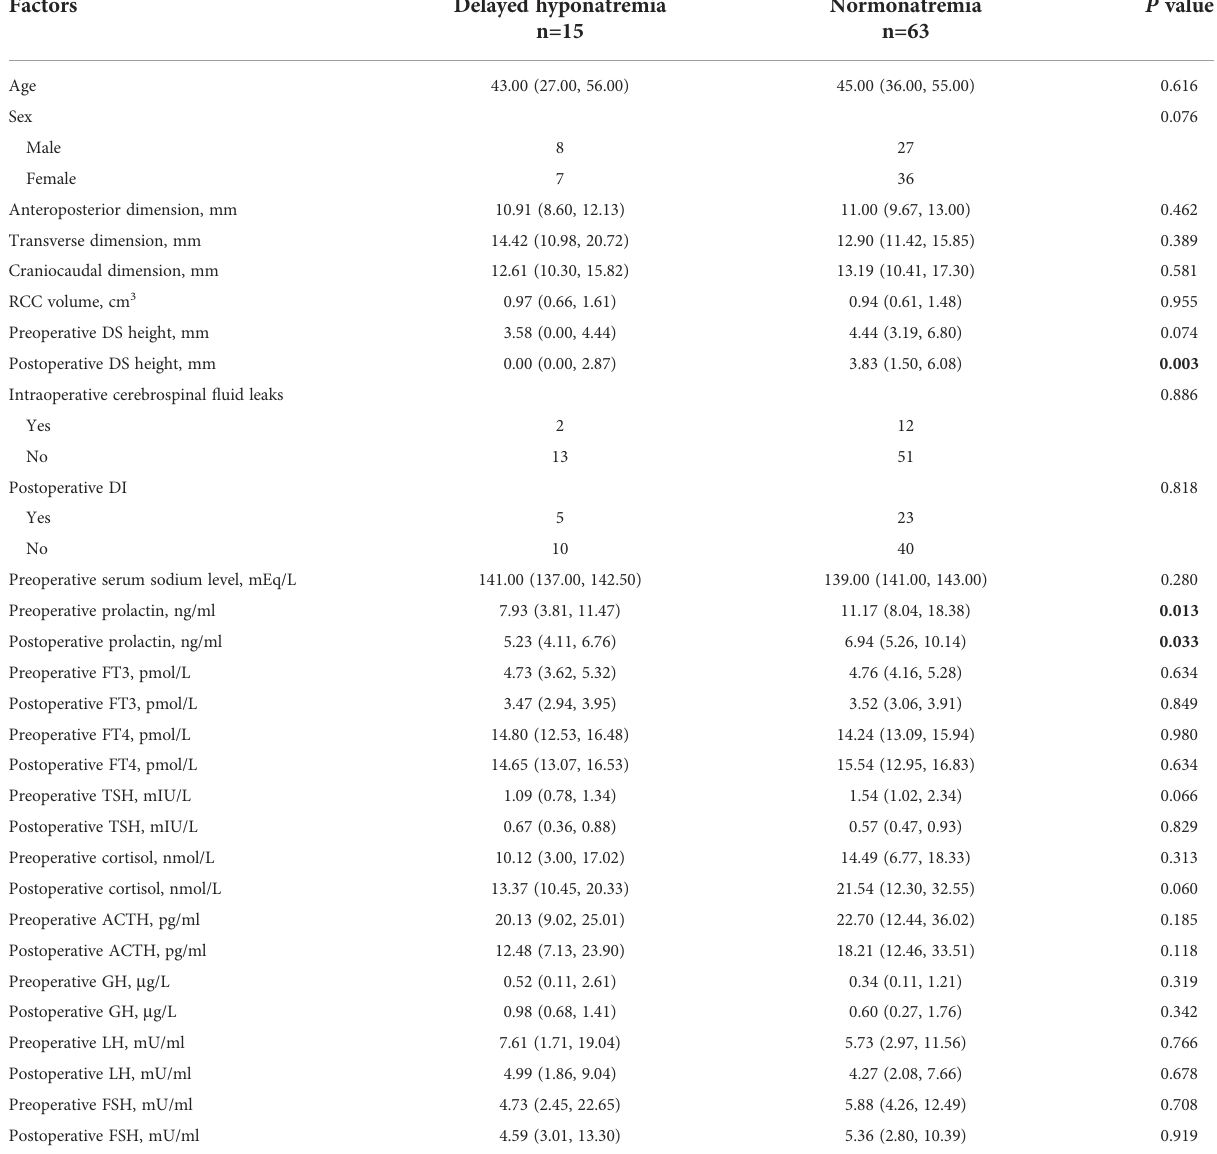
TABLE 1 The comparison of factors between the delayed hyponatremia group and the normonatremia group.